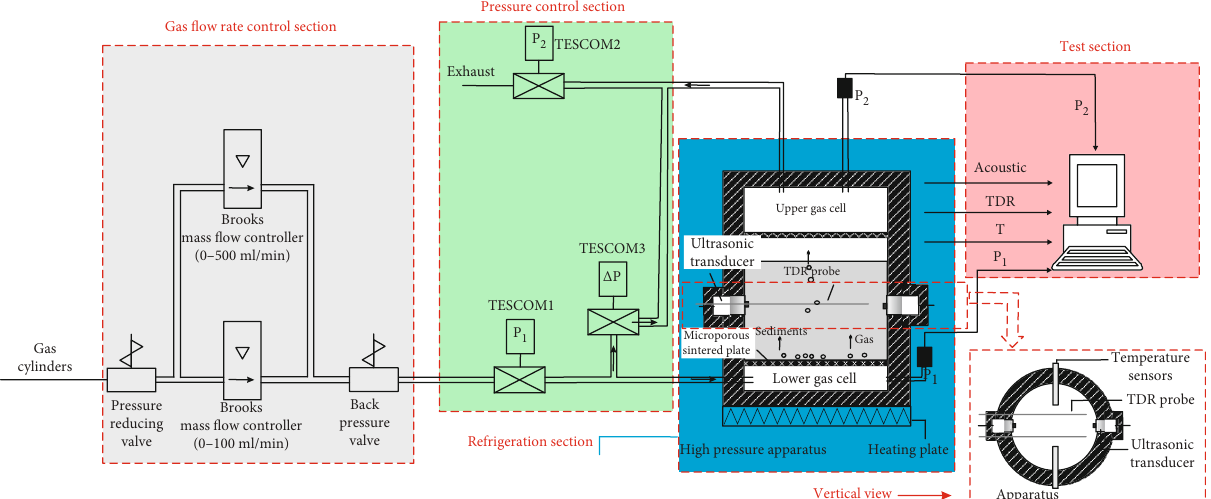
Figure 1: An experimental device for gas hydrate formation and acoustic velocity detection with di ff erent methane fl ux (Modi fi ed from